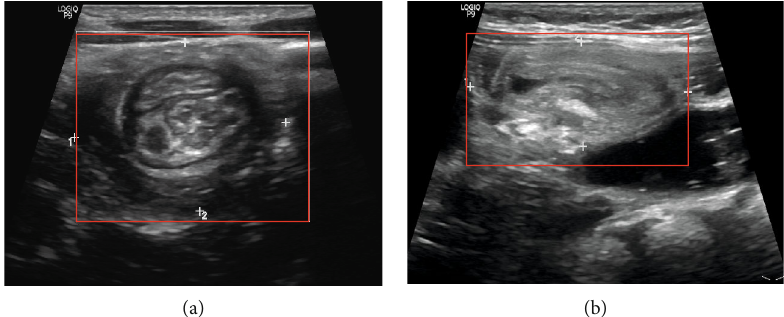
Figure 1: Signs of “ concentric circles ” at di ff erent angles. A child diagnosed with intussusception (female, 2 years old) presents with abdominal pain, vomiting, hematochezia, and abdominal mass. The “ concentric circle ” area is marked with a white cross: (a) easy to observe and (b) hard to observe.